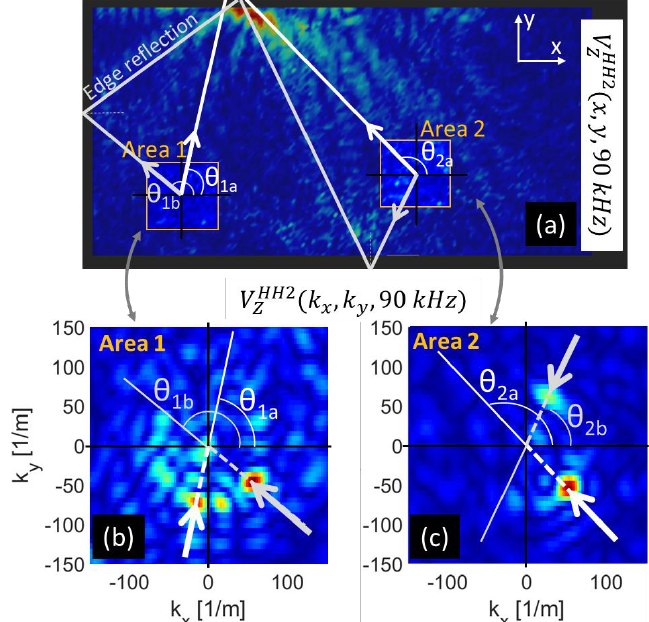
Figure 9. Detection of out-of-sight side-damage by using the second harmonic component measured at two small areas: ( a ) second harmonic amplitude map at 90 kHz with indication of the measurement areas, ( b , c ) wavenumber maps corresponding to the second harmonic component at 90 kHz with indication of the direction of the incoming wavefield.